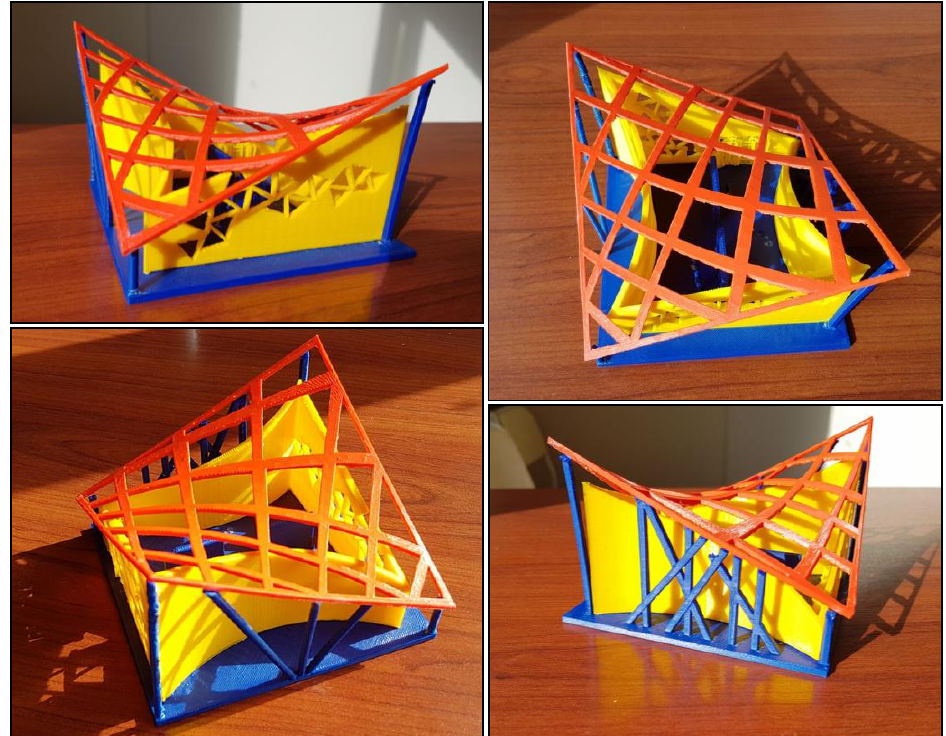
Figure 4. 3D printed model of the exhibition form via Ultimate 3D